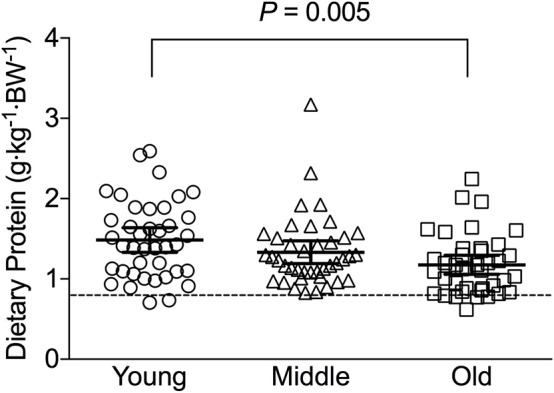
Average relative daily protein intake in young, middle-aged and older individuals. Scatter plots display mean with 95% confidence intervals. Dashed line indicates current recommended daily allowance for dietary protein allowance of 0.8 g·kg−1·day−1.